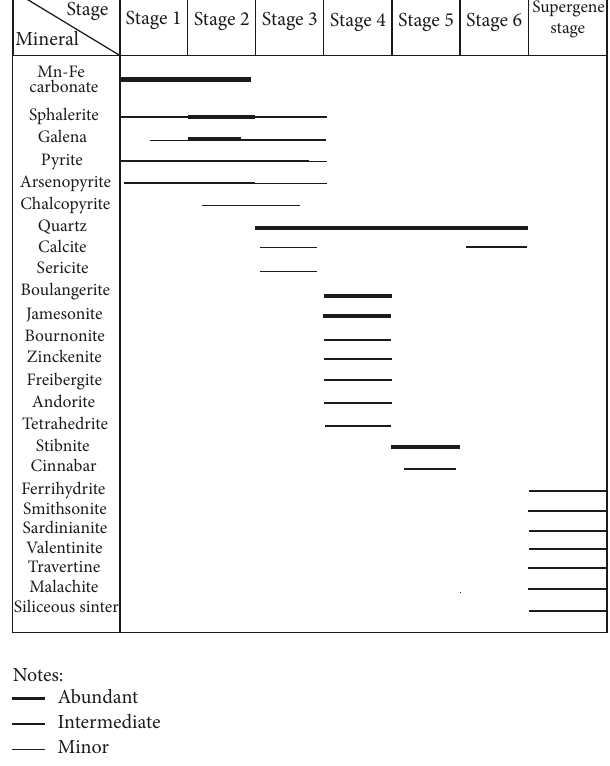
Figure 3: Mineral paragenesis within the Zhaxikang Sb-Pb-Zn-Ag deposit (modified from Wang et al.